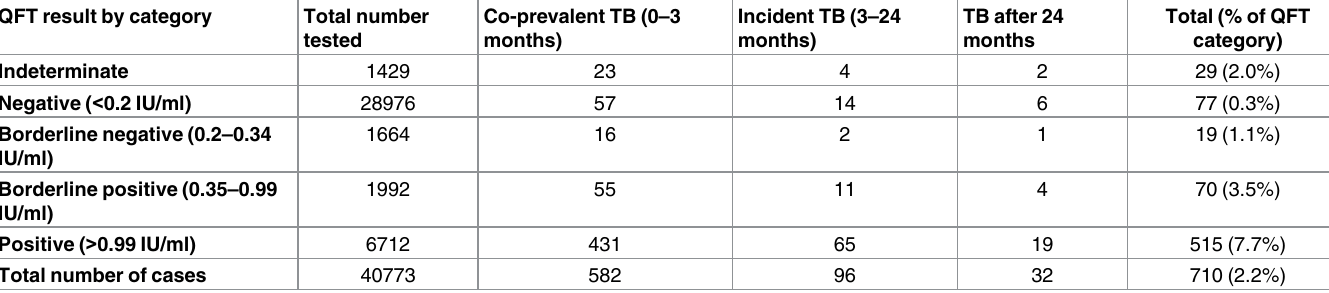
Table 2. Number of cases of active TB (n = 710) per QFT result and time of diagnosis in relation to time of the QFT